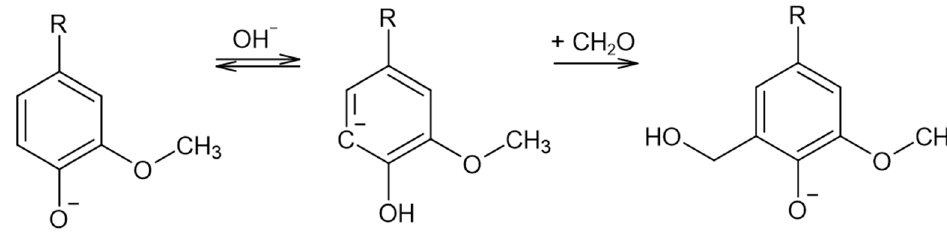
Figure 2. The Lederer–Manasse reaction (adapted from [4,22]).